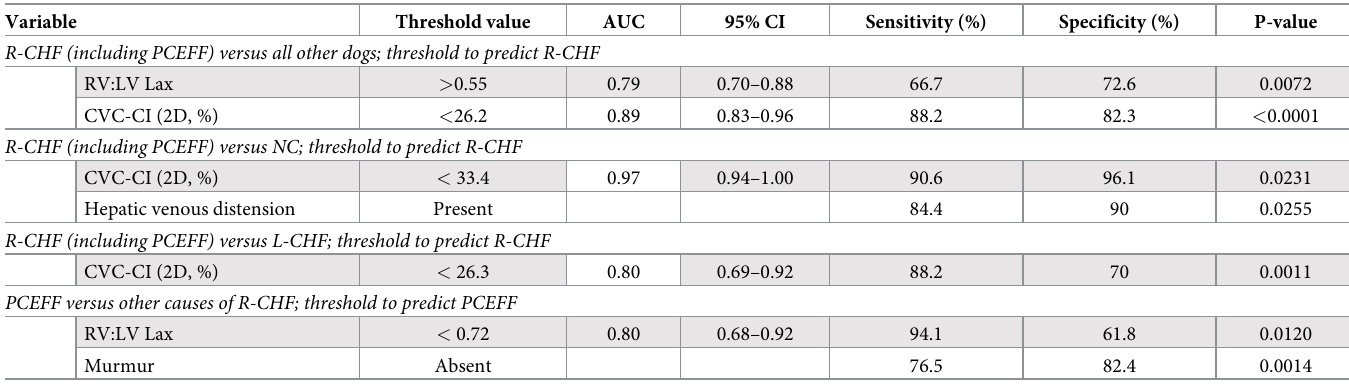
Table 4. Clinical and sonographic variables useful for predicting disease group.